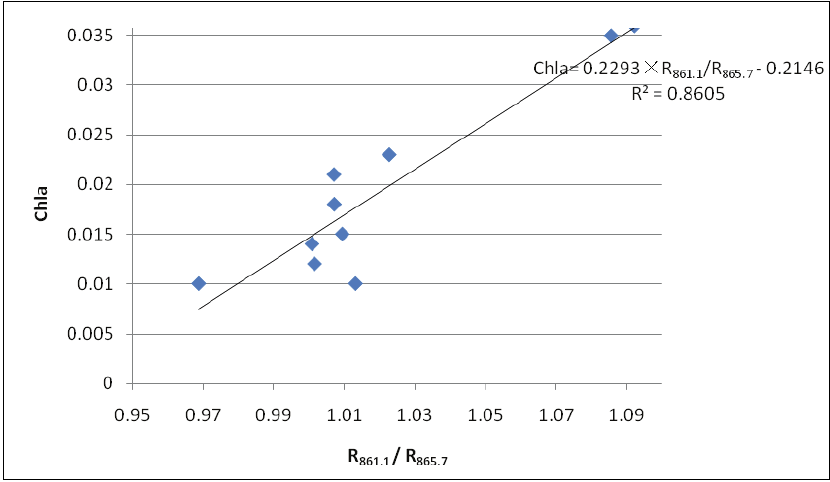
Figure 10. Scatter plots of Chl- a versus reflectance ratio R